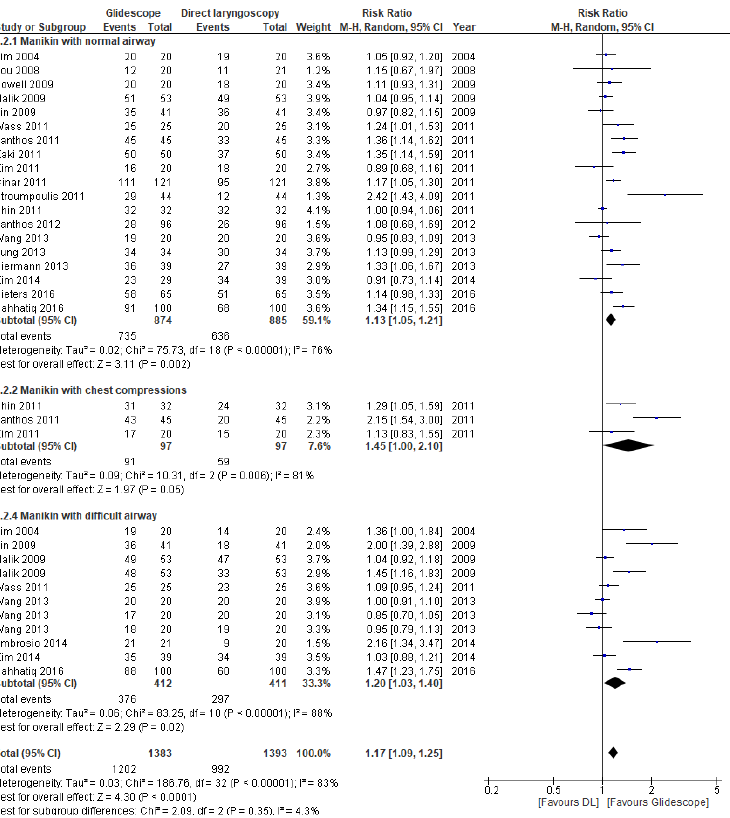
Figure 6. Risk ratios (RR) of successful first-attempt intubation in manikin trials comparing Glidescope ® videolaryngoscopy to direct laryngoscopy. The pooled estimate (rhombus) was derived using the DerSimonian and Laird random effects method. The squares depict individual study point estimates of the RR. Horizontal lines display the 95% CI of the point estimate. The vertical line represents an RR of 1.00 indicating no difference between Glidescope ® videolaryngoscopy and direct laryngoscopy; DL = direct laryngoscopy, GS = Glidescope ® videolaryngoscopy). Ambrosio, 2014 [32]; Bahhatiq, 2016 [34]; Biermann, 2013 [29]; Cinar, 2011 [21]; Kaki, 2011 [22]; Kim, 2011 [23]; Kim, 2014 [33]; Lim, 2004 [16]; Lin, 2009 [17]; Malik, 2009 [18]; Pieters, 2016 [35]; Powell, 2009 [19]; Shin, 2011 [25]; Stroumpoulis, 2011 [26]; Tung, 2013 [30]; Wang, 2013 [31]; Wass, 2011 [24]; Xanthos, 2011 [27]; Xanthos, 2012 [28]; You, 2009